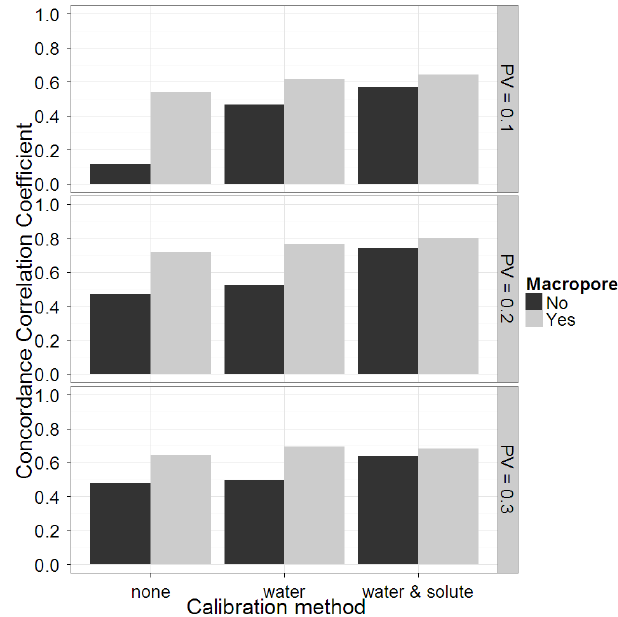
Fig. 5. Concordance correlation coefficient (CCC) of measured ver- sus simulated accumulated solute loads leached at 0.1, 0.2 and 0.3 pore volumes for different calibration methods: no calibration (only pedotransfer functions); after calibration of 2 water-related crop pa- rameters; after calibration of 2 additional solute-related crop and soil parameters. Darker bars represent simulations where solute macropore flow has been “switched-off”, and grey bars represent (standard) simulations where macropore flow parameters have been parameterised according to the pedotransfer functions. Some soil profiles are not included in the CCC calculation at 0.2 and 0.3 pore volumes, because not all the lysimeters had this much drainage.